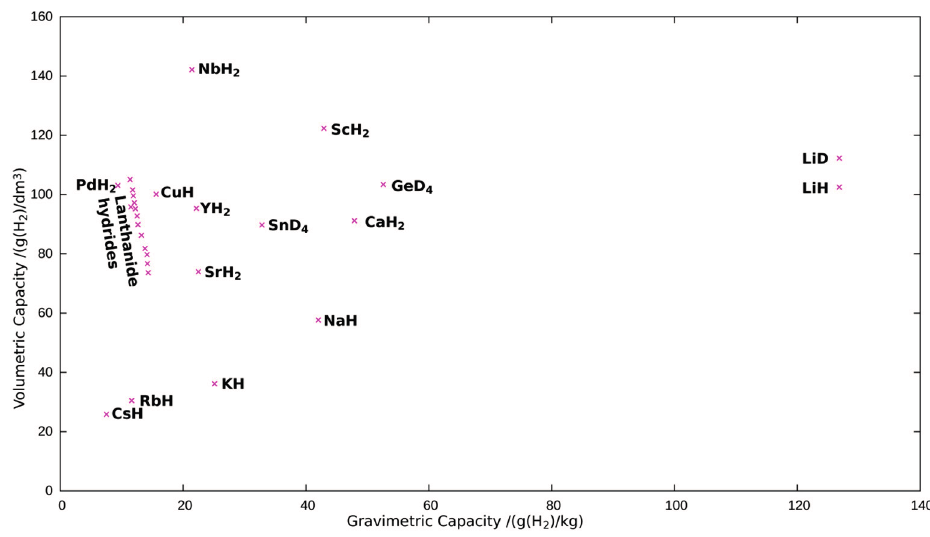
Figure 5. Plot of the hydrogen storage capacities of the binary metal hydrides (magenta crosses) included in the COD